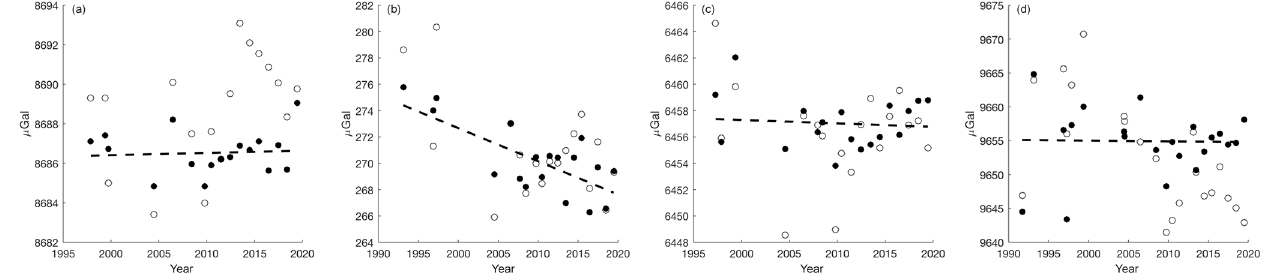
Figure 1. Pre-processed gravity data before (circles) and after (dots) corrections for offset and estimated water table variations were ap- plied. The dashed line shows the estimated linear trend based on offset and water table corrected pre-processed gravity data. From (a) to (d) : Westerbork, Epen, Zundert, Radio